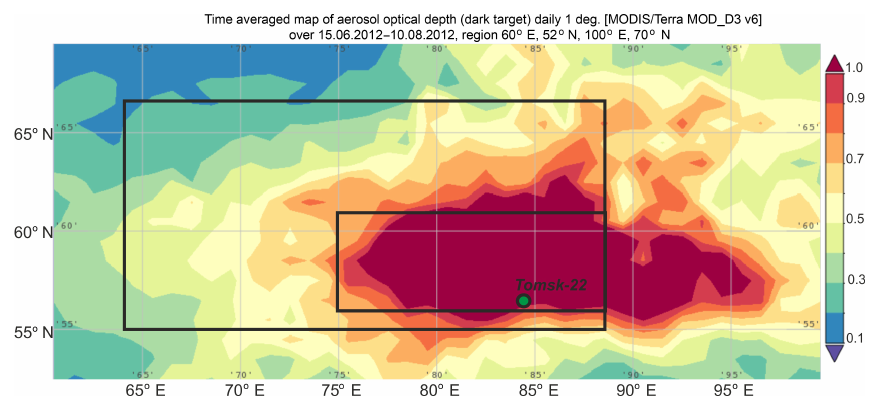
Figure 5. Spatial distributions of AOD (MODIS collection 6) over Western and Eastern Siberia during 15 June–10 August 2012. The central part of Western Siberia (55–62 ◦ N; 64–88 ◦ E) and the Tomsk region (56–61 ◦ N; 75–88 ◦ E) are highlighted by boxes.